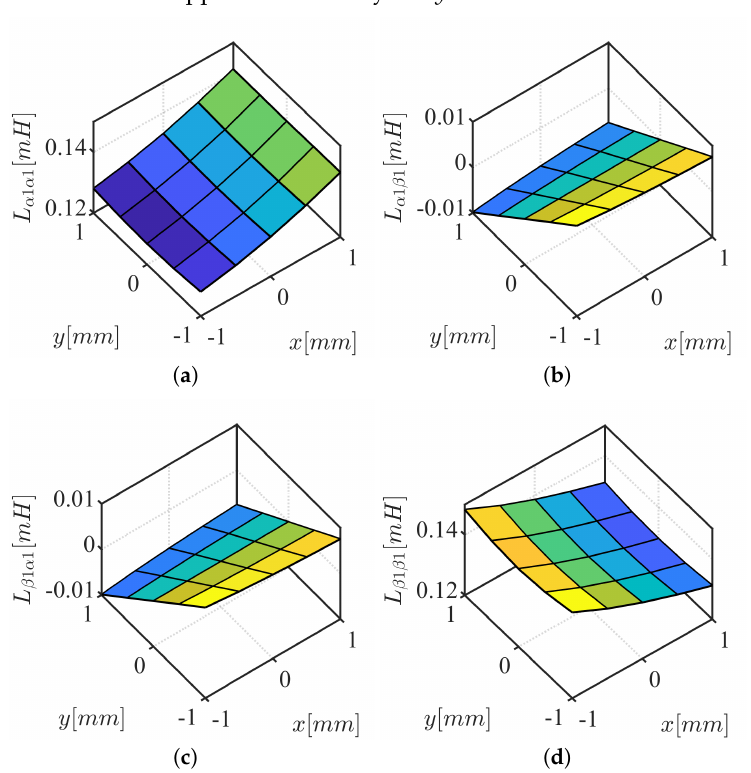
Figure 5. αβ 1 inductance results from FEA: ( a ) L α 1 α 1 ; ( b ) L α 1 β 1 ; ( c ) L β 1 α 1 ; ( d ) L β 1 β 1